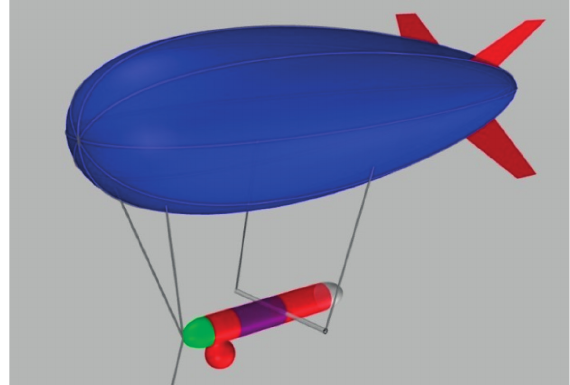
Fig. 3. K28 aerostat